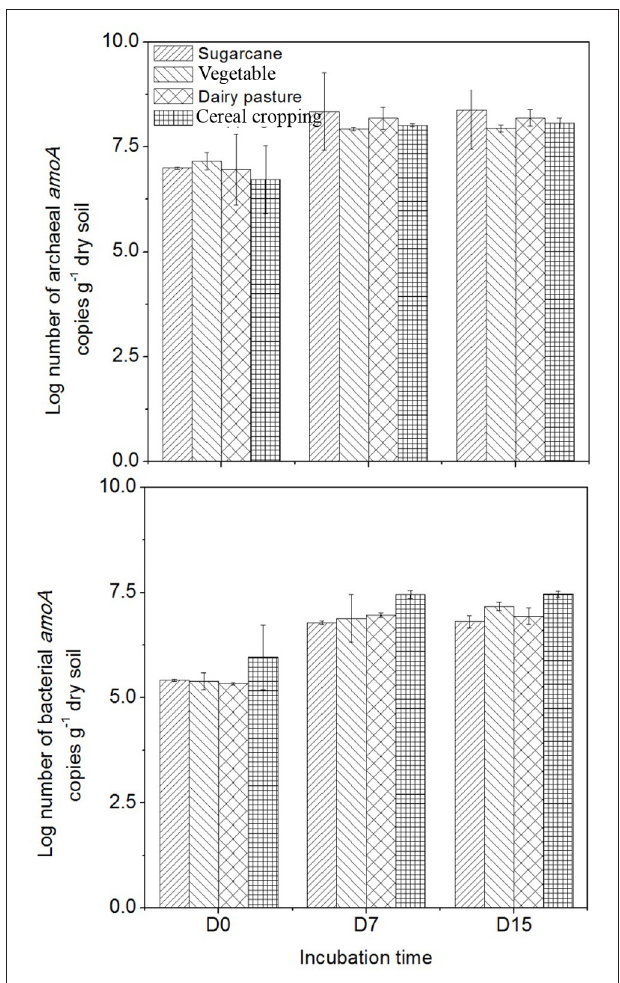
FIGURE 3 | Changes in AOA and AOB amo A gene copy numbers in the 15 NH 4 treatment during the incubation period. Error bars represent standard